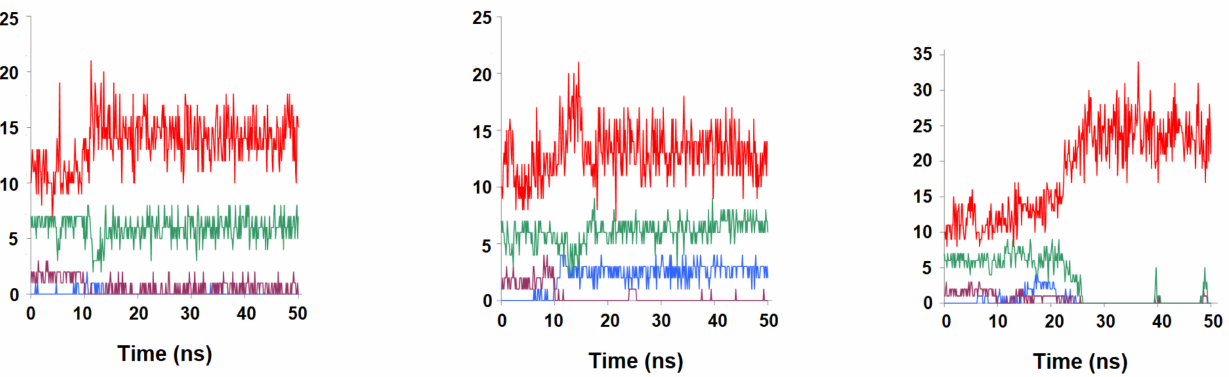
Figure 3. Evolution of contacts between the N 5 -protonated dihydropterin core (molecule 1 ) and R67 DHFR along multiple simulations. red: number water molecules < 3 Å from the ligand; green: number of amino acid residues < 3 Å from the ligand; violet: number of H-bonds between protein surface and the ligand; blue: number of H-bonds between NADPH and the